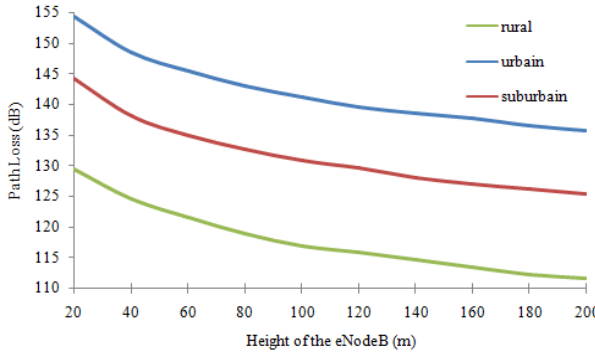
Figure 2. Influence of distance and type of medium on propagation.